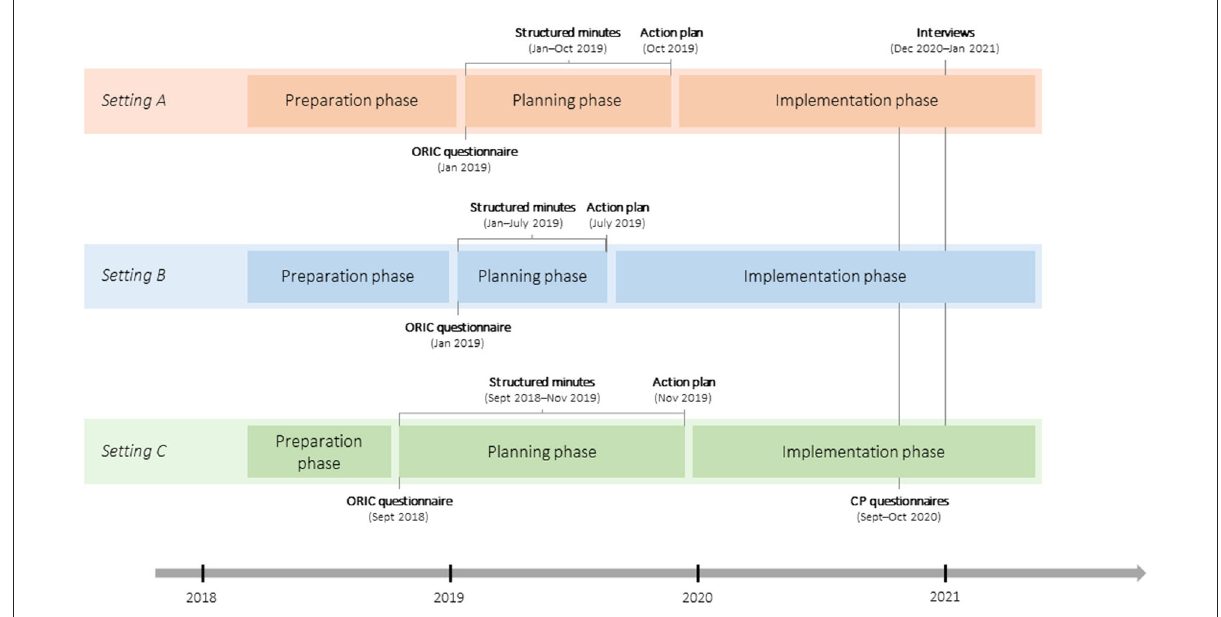
FIGURE2 Cooperative planning processes and moments of data collections. CP, cooperative planning; ORIC, organizational readiness for implementing change.